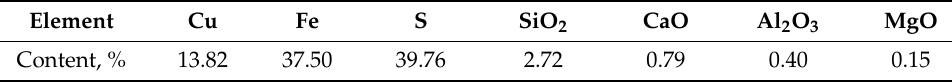
Table 1. The main element contents of mineral samples.